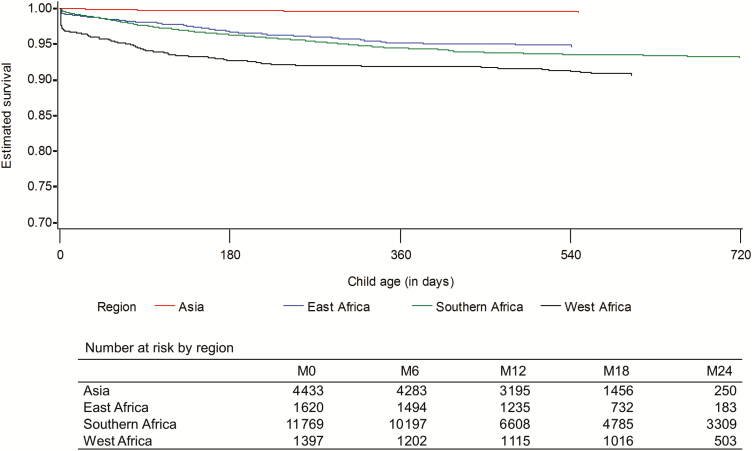
Kaplan-Meier estimates of 24-month survival from birth by geographical region.